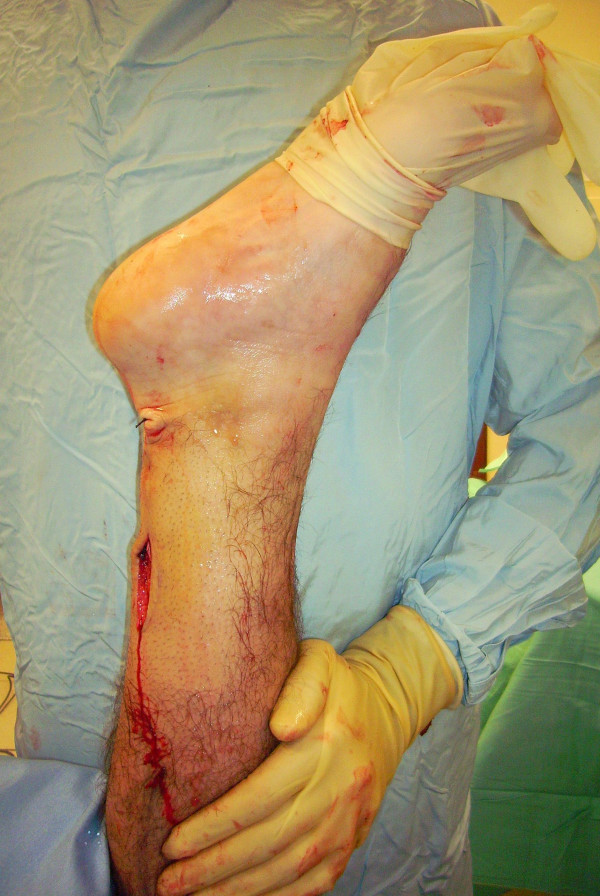
The final result.